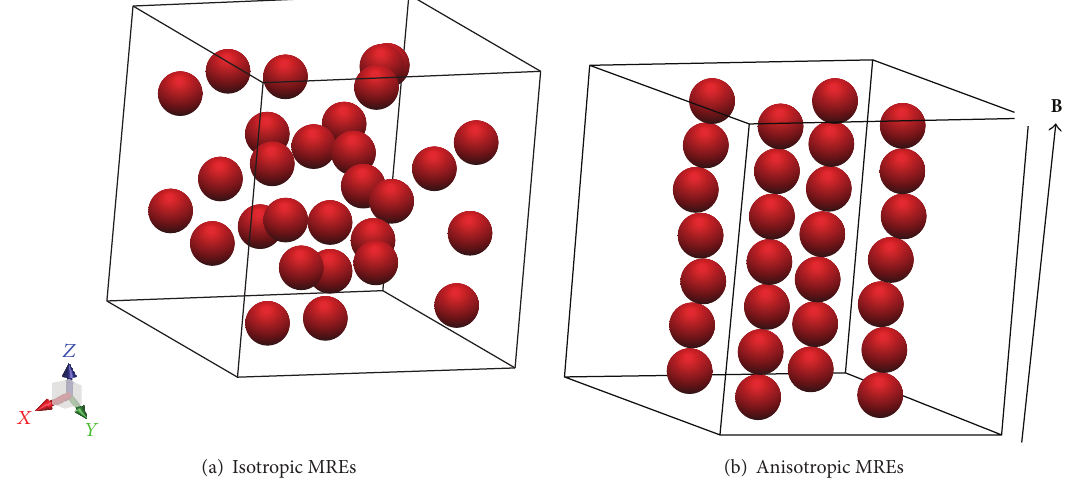
Figure 1: Sketches of